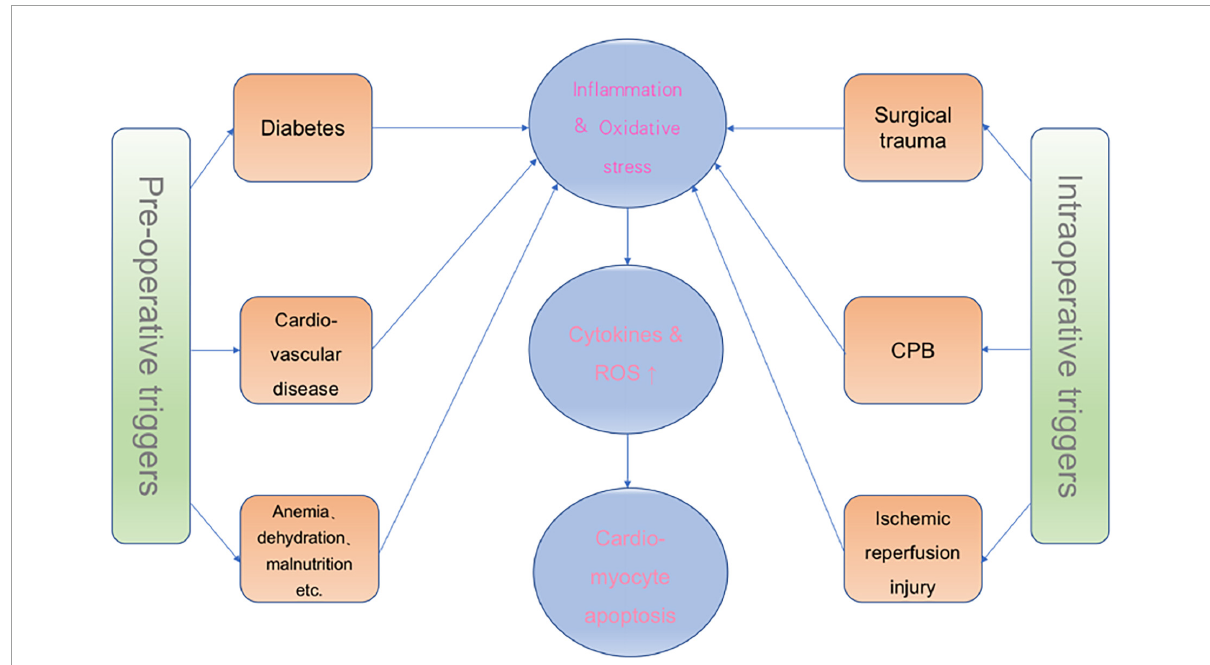
FIGURE2 Effects of CPB and ischemia-reperfusion injury on POD and the source of ROS. NAPDH II, NADPH oxidase 2; HK II, hexokinase II; MAPK, mitogen-activated protein kinase; NF-kB, nuclear transcription factor- κ B; TNF- α :tumor necrosis factor- α ; BBB, blood-brain barrier; MPTP, mitochondrial permeability transition